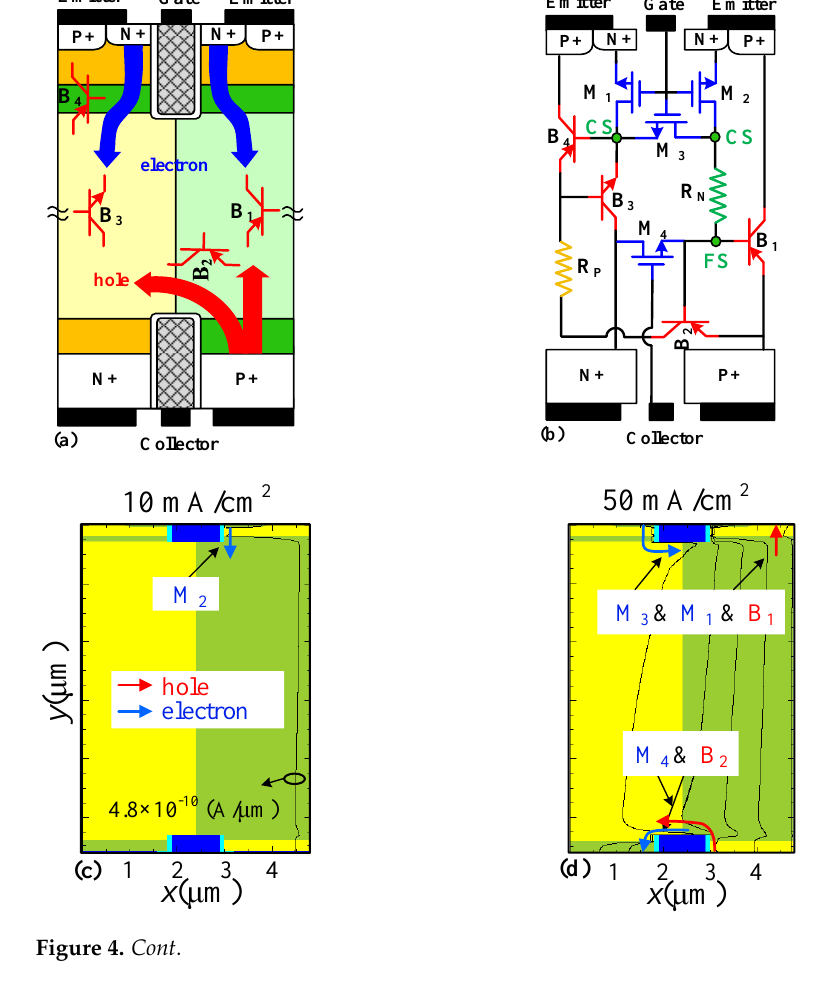
Figure 3. The reverse conduction and equivalent circuit of SJ-RC-IGBT. ( a ) Reverse-conducting mechanism. ( b ) Equivalent circuit at reverse conduction. Reverse-conducting current distribution of SJ-RC-IGBT at ( c ) 10 mA/cm 2 , ( d ) 40 mA/cm 2 , ( e ) 70 mA/cm 2 , and ( f ) 500 mA/cm 2 . The bias condition of reverse conduction is that the collector and gate are grounded, and the emitter is positively biased. All the contours of current density are 4.8 × 10 −10 A/µm. Blue arrows represent electron injection and red arrows represent hole injection.